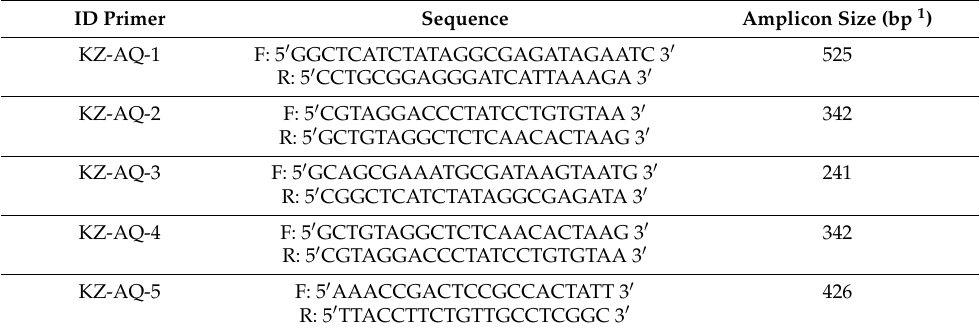
Table 3. Specific PCR primer sets for Kretzschmaria zonata detection.